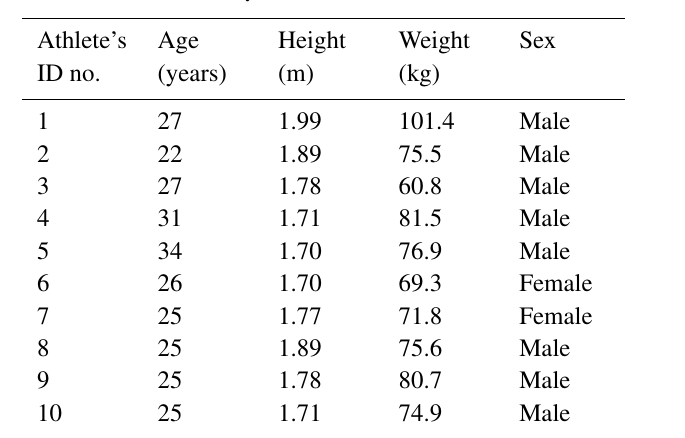
Tab.2: Physical data of the ten athletes.